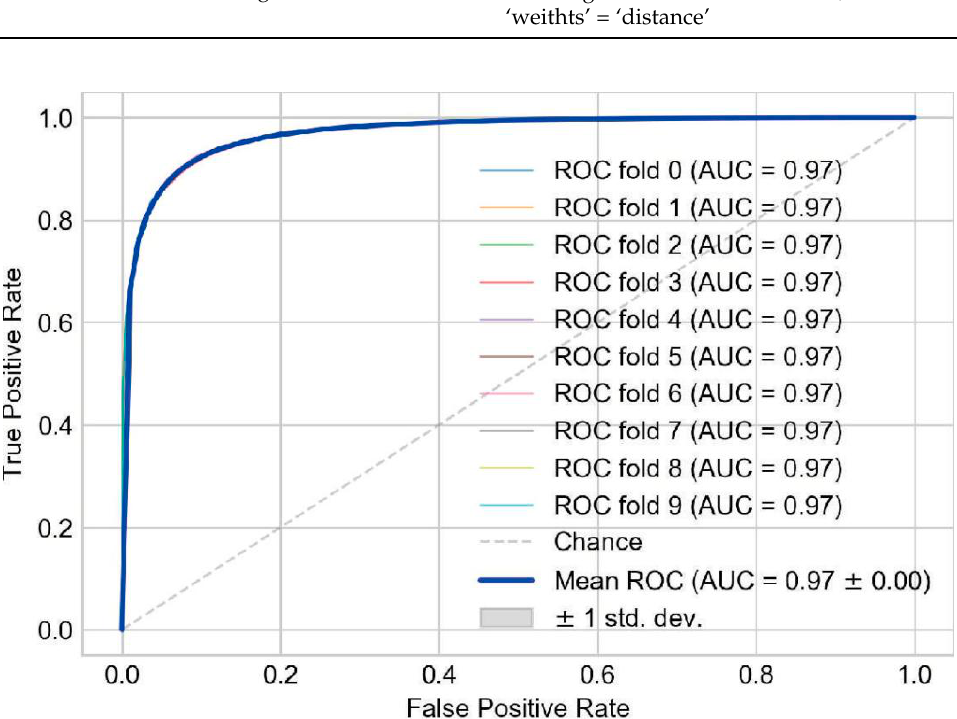
Figure 9. Receiver Operating Characteristic Curve (ROC) and AUC of ExtraTrees using 10-time cross validation. Table 3. Model optimal super parameter results and the time consumed. (Note: Please refer to the Scikit ‐ learn website for the explanation of each parameter and its role in model adjustment: